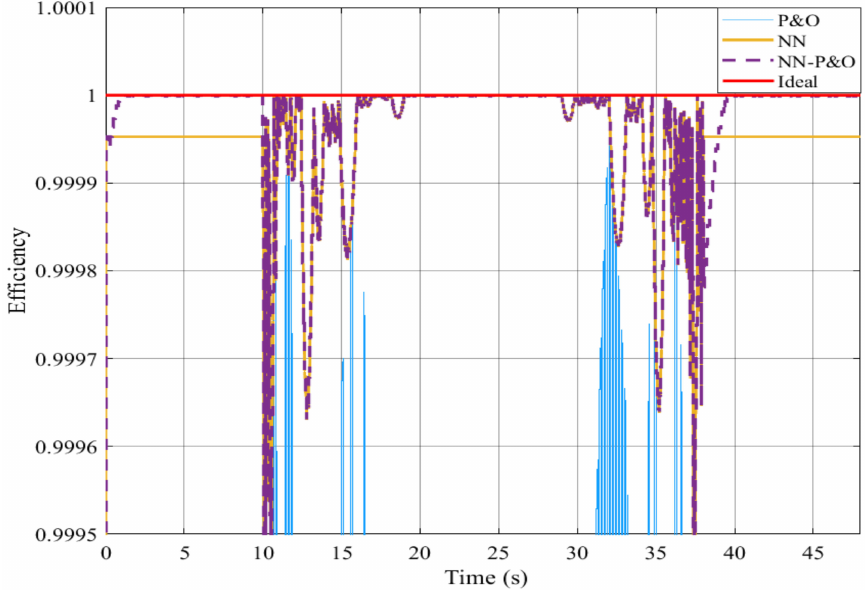
Figure 11. Efficiency of three MPPT methods under a slope of 100 W/m 2